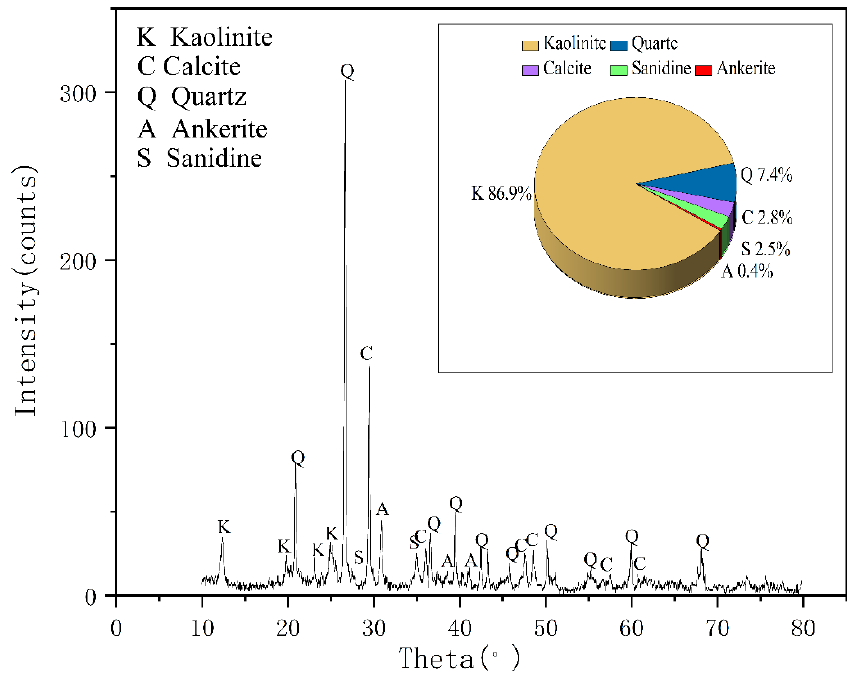
Figure 2. The mineral XRD analysis results plot.